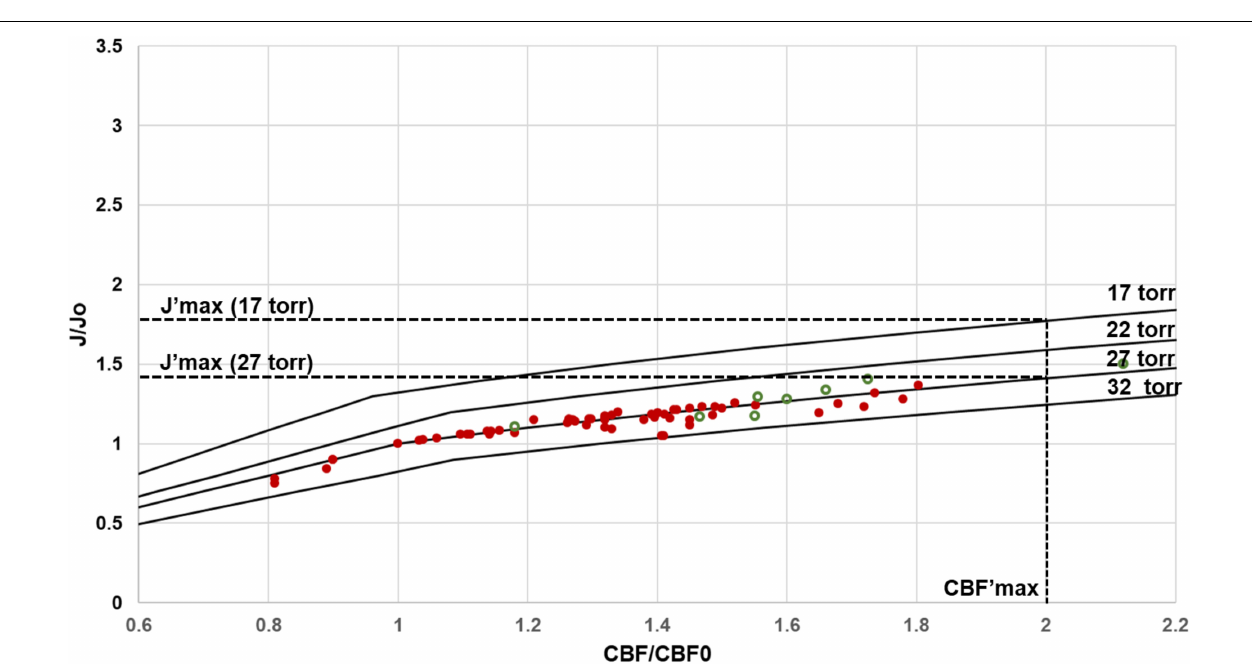
FIGURE 7 | Predicted regional J/Jo (J (cid:48) ) versus regional CBF/CBF o (CBF (cid:48) ) for different values of PO 2T avg . At the measured value of OEF o = 0.40, human (red filled circles) and rat (green open circles) data closely agree with the J (cid:48) versus rCBF (cid:48) curves calculated with an activity independent PO 2T of ∼ 27 torr. Note that even small variations in PO 2T avg would be detectable. Regional CMRO 2 in principle can be increased by reducing PO 2T avg . For the lowest value of PO 2T avg required to support mitochondrial function, approximately 17 torr, J (cid:48) max (at CBF (cid:48) max of 2.00) is 1.75, versus 1.42 at the physiological PO 2 T avg value of 27